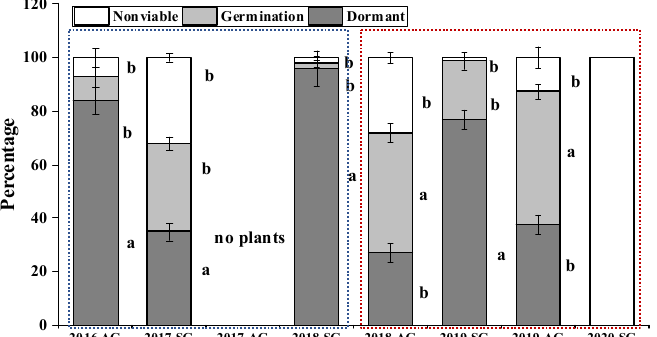
Figure 13. Nonviable, nondormant, and dormant seeds of offspring (F2) of spring (SG)- and autumn (AG)-germinating plants of Erodium oxyrhinchum in wet ( left ) and dry ( right ) springs. Different lowercase letters indicate significant differences ( p < 0.05) among SG and AG in dry and wet springs. Vertical bars indicate standard errors of the means (n = 4).